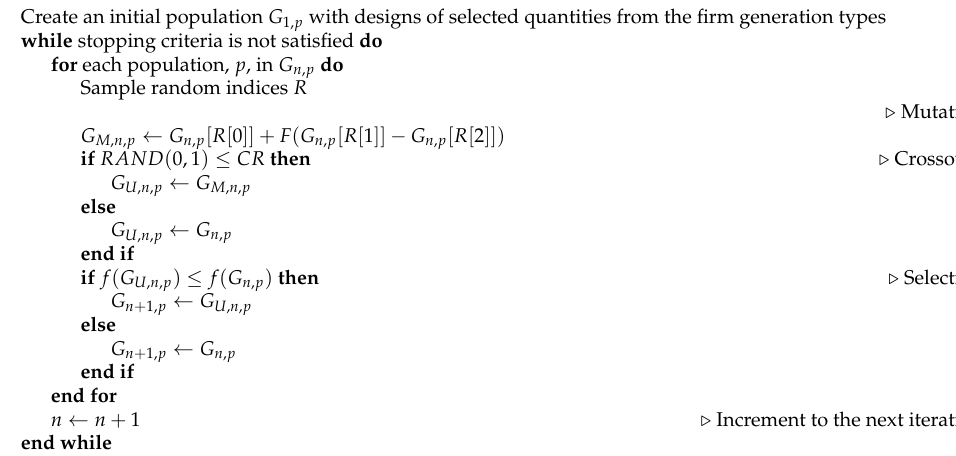
Algorithm 1 Pseudo-code of the implemented multi-objective optimization algorithm for economic load dispatch based on differential